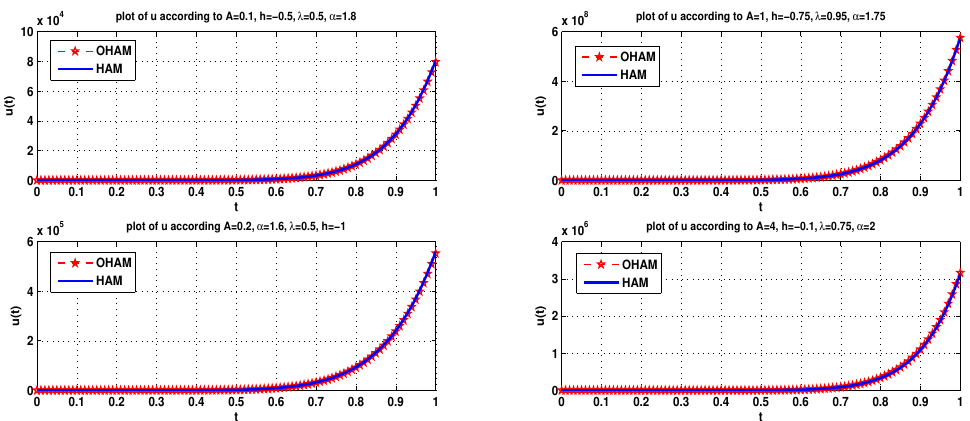
Figure 6. Graphical comparisons between the OHAM and HAM for different values of A , λ , α and h